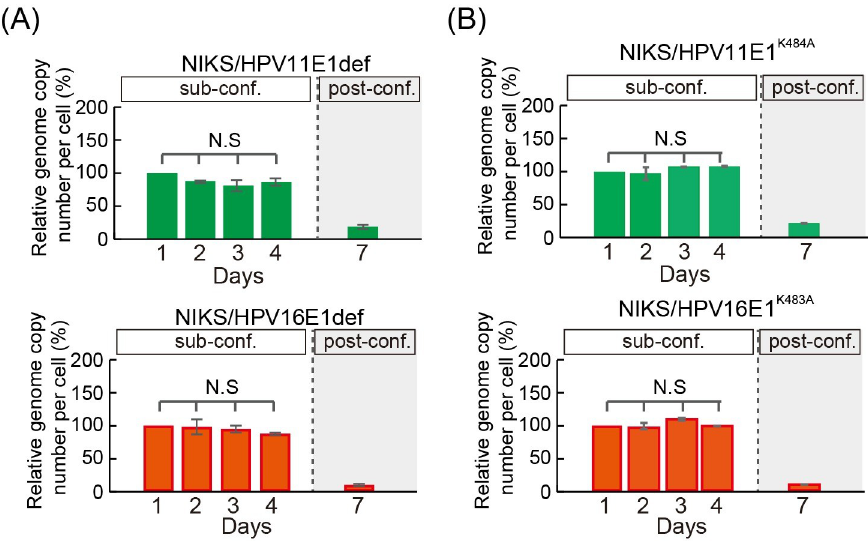
Fig 3. Requirement of a helicase-active E1 for genome amplification but not maintenance. (A) The virus genome copy number per cell of E1-defective HPV11 (HPV11E1def, upper) and HPV16 (HPV16E1def, lower)